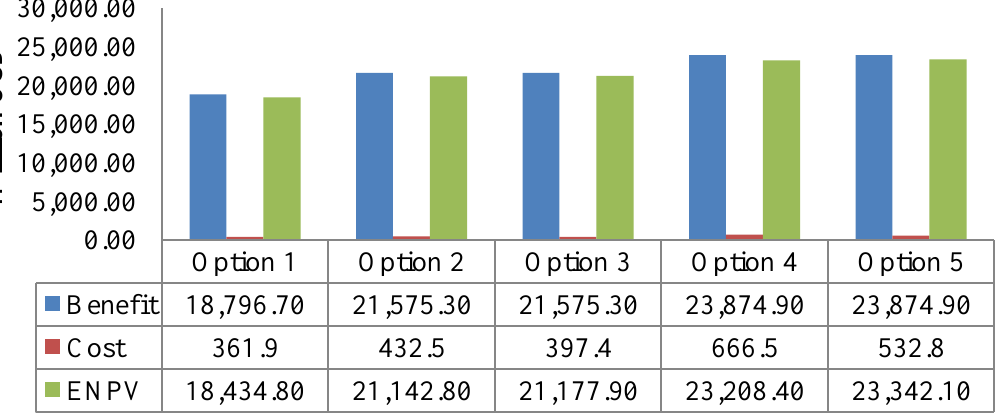
Figure 3. Cost-benefit analysis of sea dike options with uncertainty conditions (discount rate =